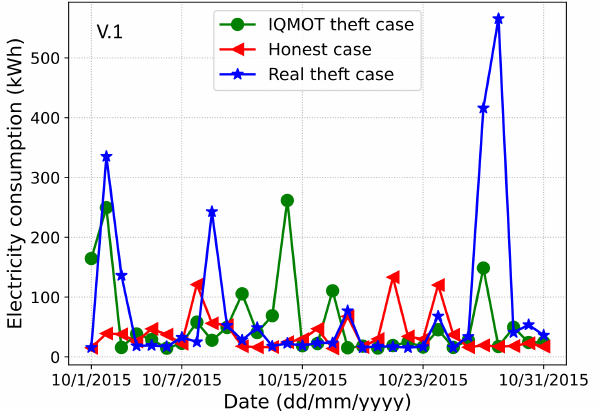
Figure 3. Example of IQMOT0based sample generation of October